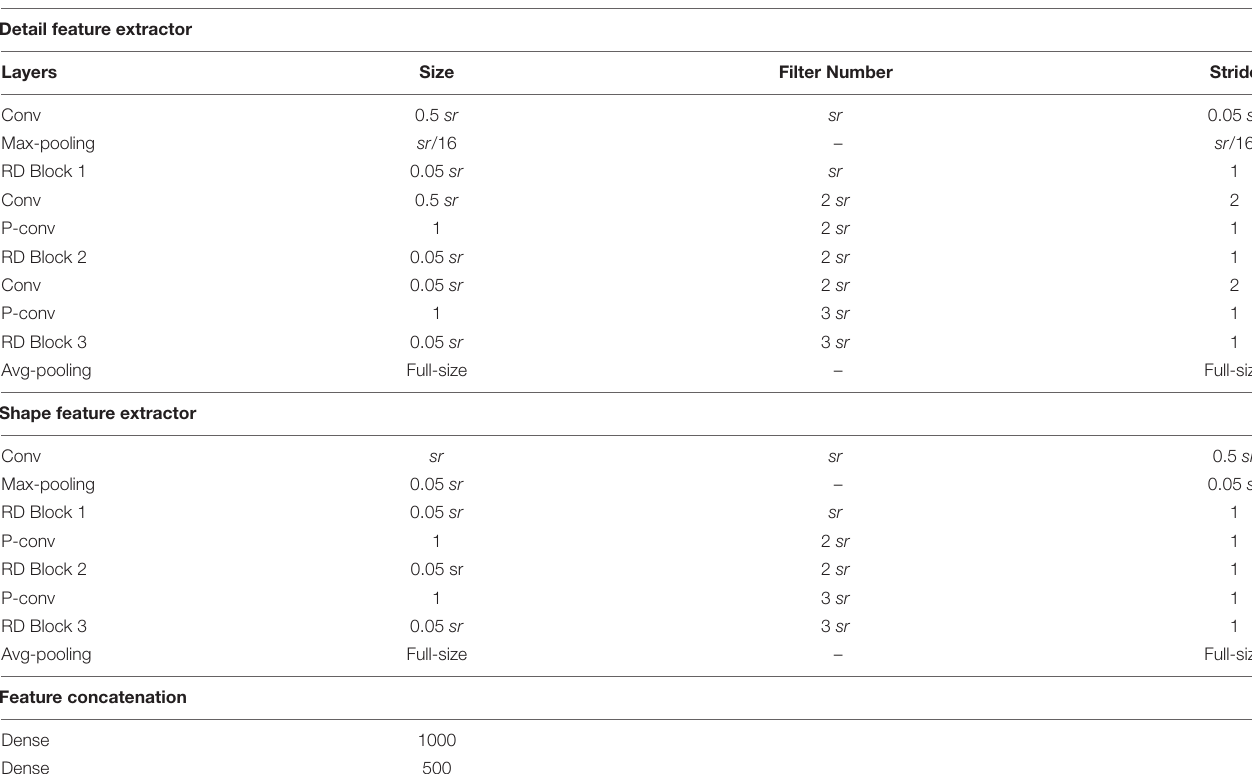
TABLE TA1 | Specifications of the